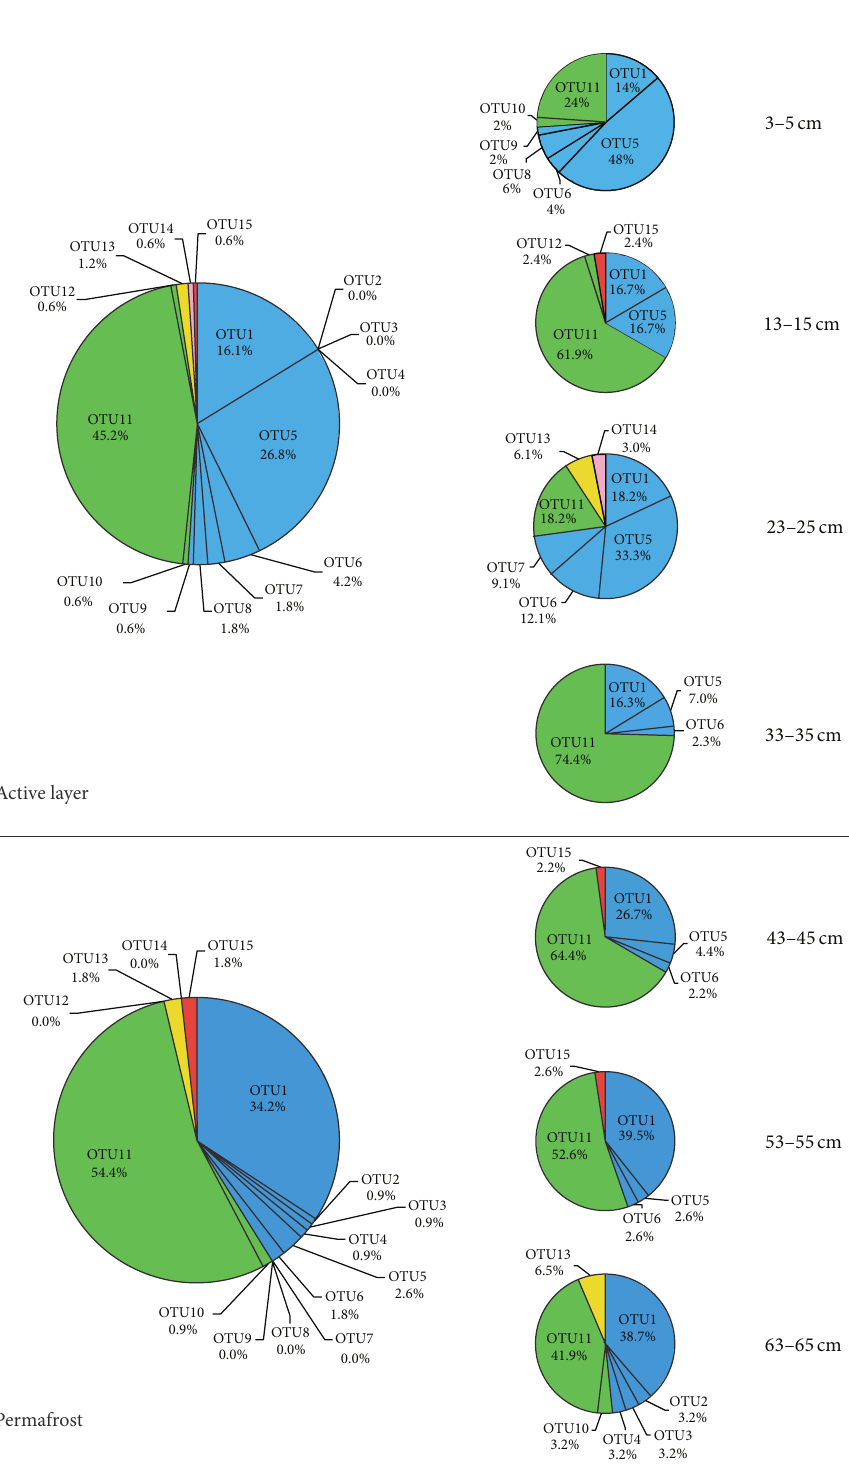
Figure 2: Frequency of individual types (OTU) and relative depth-dependent distribution of groups of the archaea from the stratigraphic permafrost profile based on the gene clone libraries. Green segments indicate OTUs belonging to unclassified Euryarchaeota , blue segments indicateOTUsbelongingtoGroup1.3b/MCG-A,yellowsegmentsindicateOTUsbelongingto Methanosaetaceae ,redsegmentsindicateOTUs belonging to Methanosarcinaceae , and pink segments indicate OTUs belonging to Methanomicrobiales